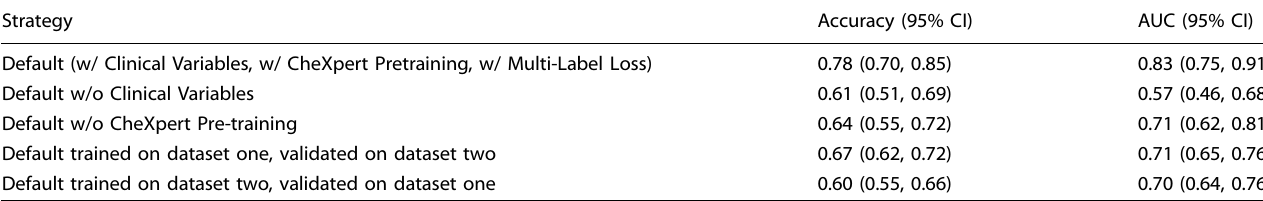
Table 2. Algorithm performance under four training strategies.